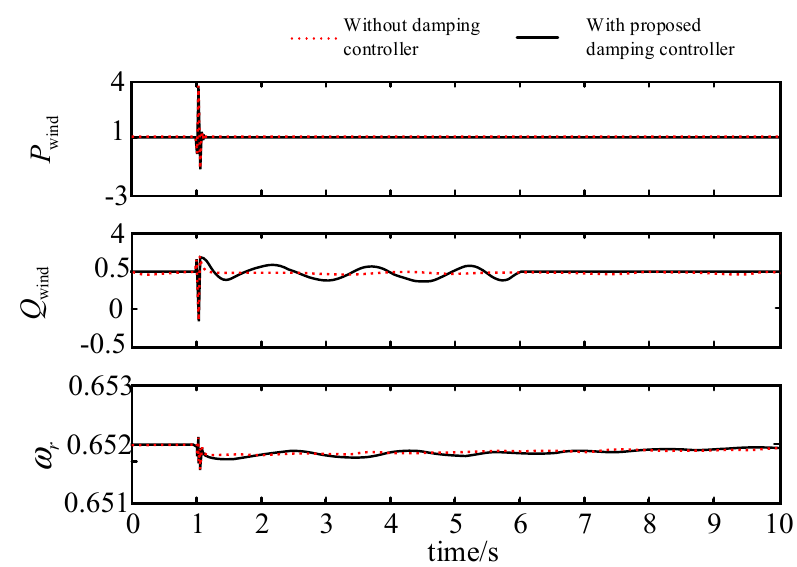
Figure 7. The dynamic reaction of DFIG in case of a malfunction in bus 1.